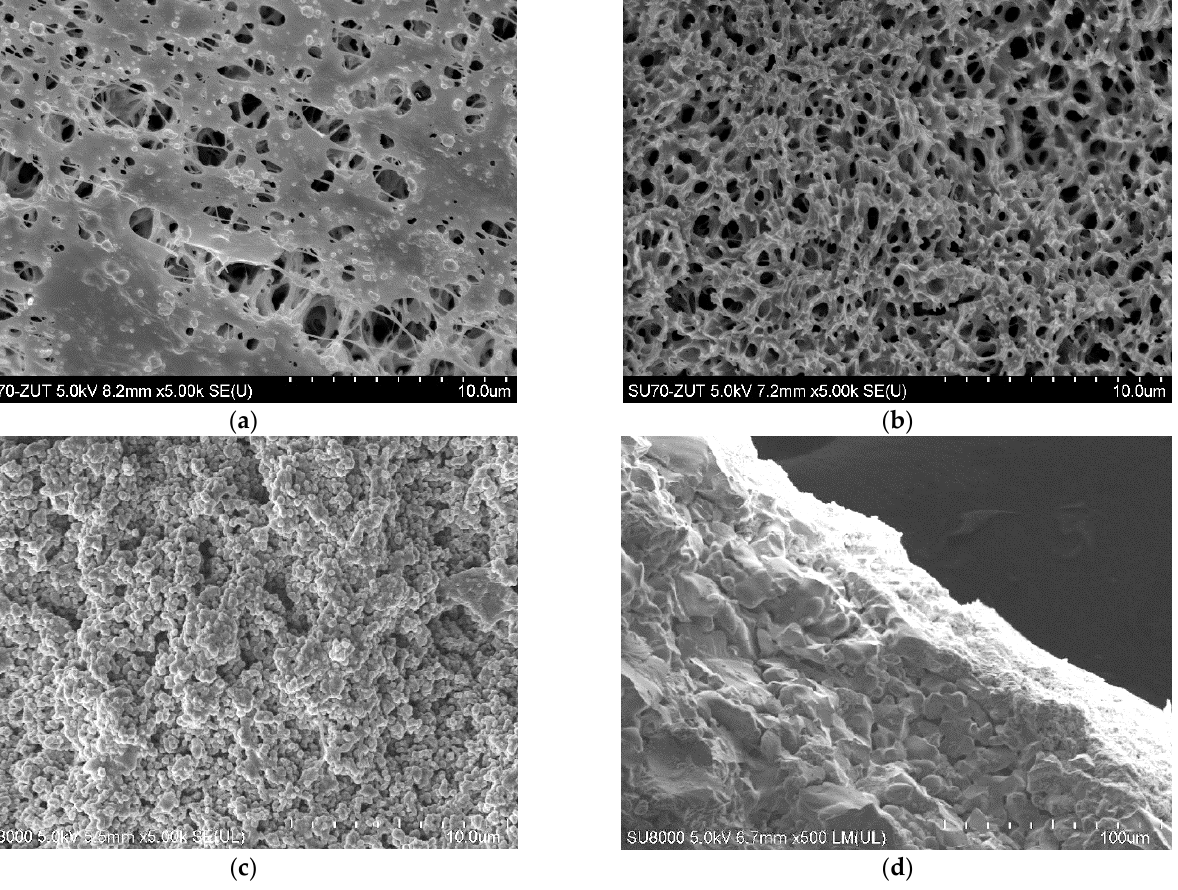
Figure 2. SEM images of tested membranes. Accurel PP S6/2 membrane: ( a ) surface, ( b ) cross-section, ceramic membrane: ( c ) surface and ( d ) cross-section.